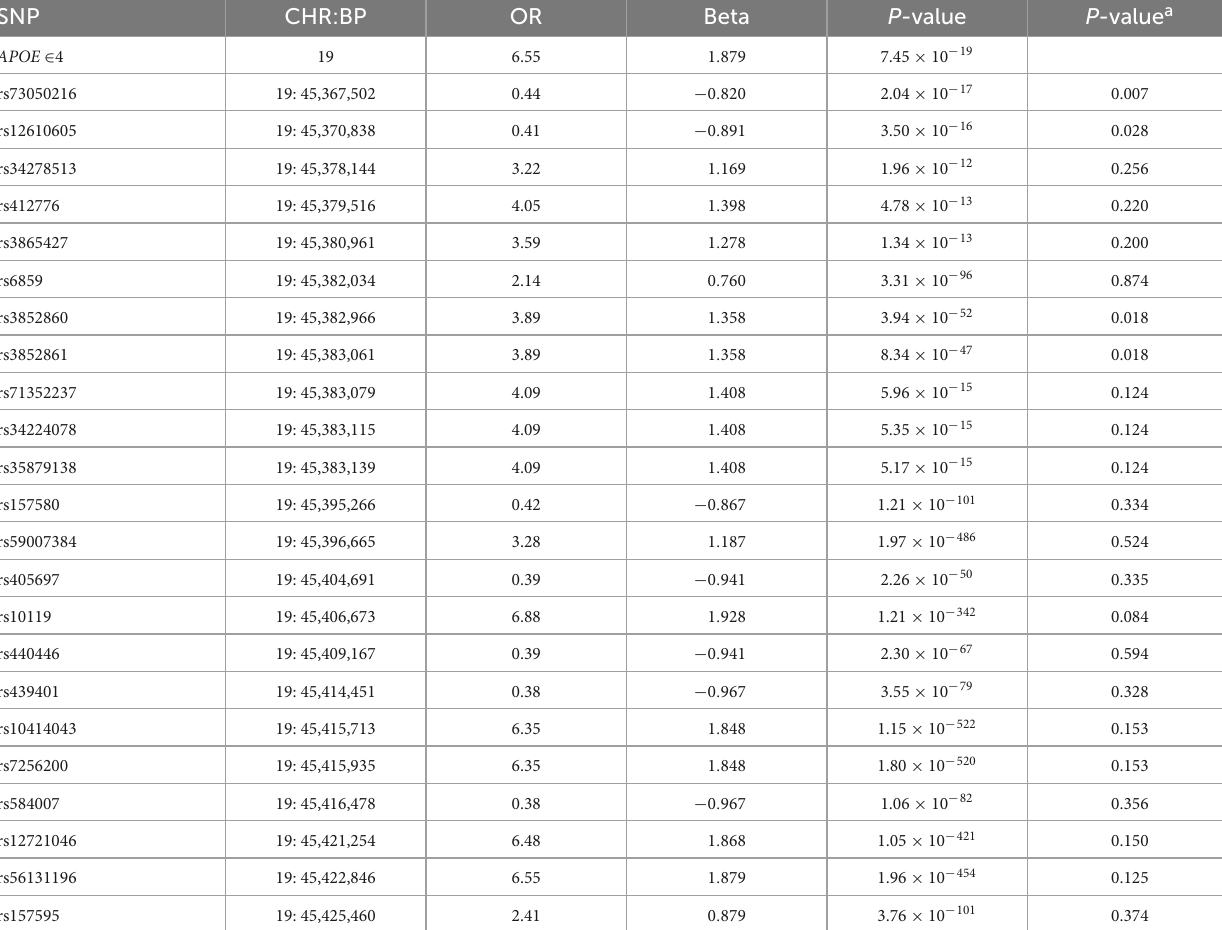
TABLE 2 A β -associated SNPs that are shared between SVCI and